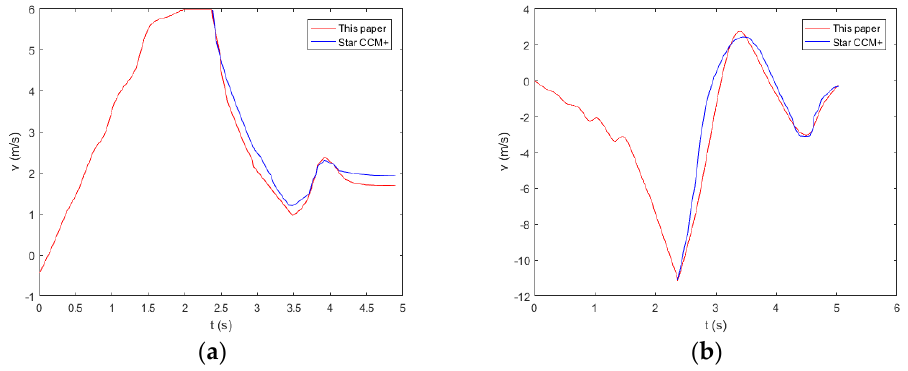
Figure 9. Velocity of center of gravity of the lifeboat in the horizontal ( a ) and vertical ( b ) direction.